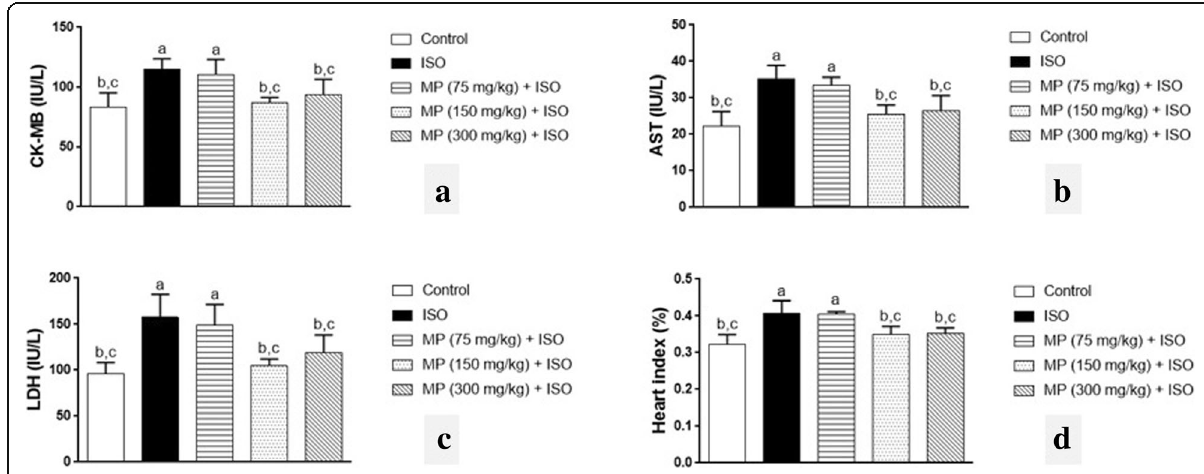
Fig. 2 Effect of different doses of MP on serum activities of CK-MB, AST, and LDH and heart index in ISO-intoxicated rats. a CK-MB. b AST. c LDH. d Heart index. Rats were pretreated with different doses of MP (75, 150, and 300 mg/kg, p.o) three times per week on alternating days for 2 weeks and then injected with 2 consecutive doses of ISO (85 mg/kg, s.c) on the 13th and 14th days; data are presented as mean ± SD ( n = 5); a, b, or c: significantly different from control, ISO, or MP 75 mg/kg groups respectively at P < 0.05 using one-way ANOVA followed by Tukey as a post hoc test. ISO isoproterenol, MP methyl palmitate, CK-MB creatine kinase myocardial band, AST aspartate aminotransferase,